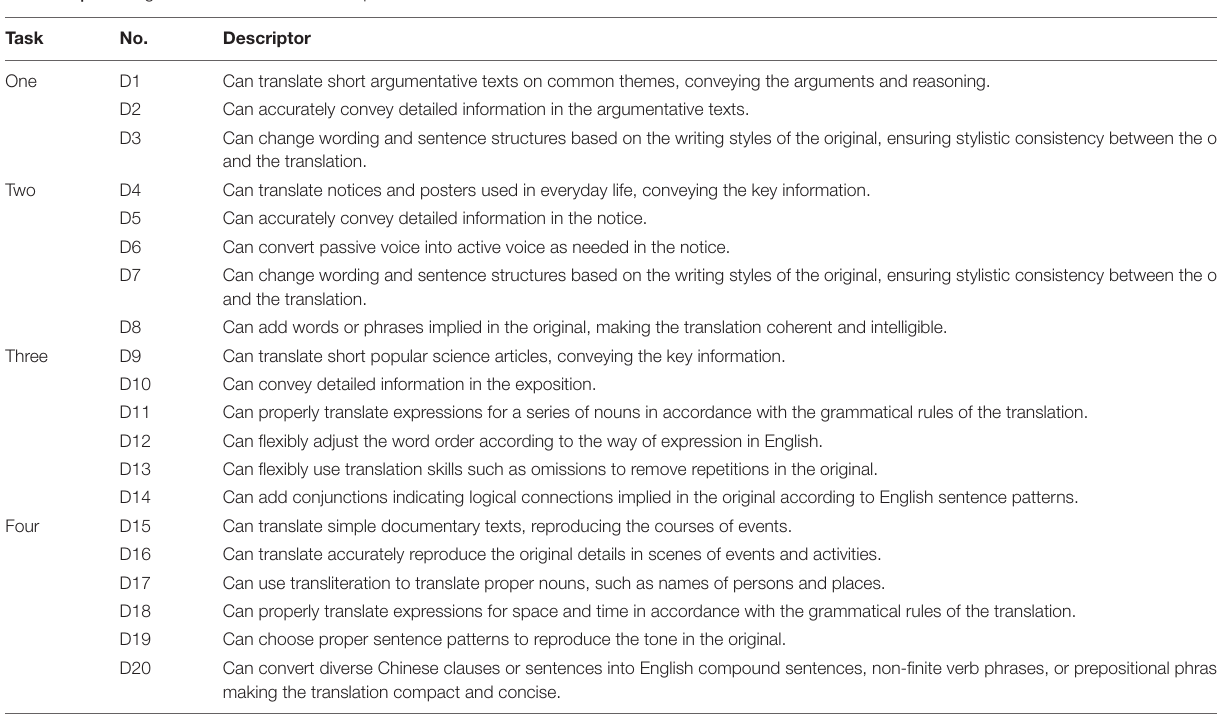
TABLE 4 | The diagnostic checklist of 20